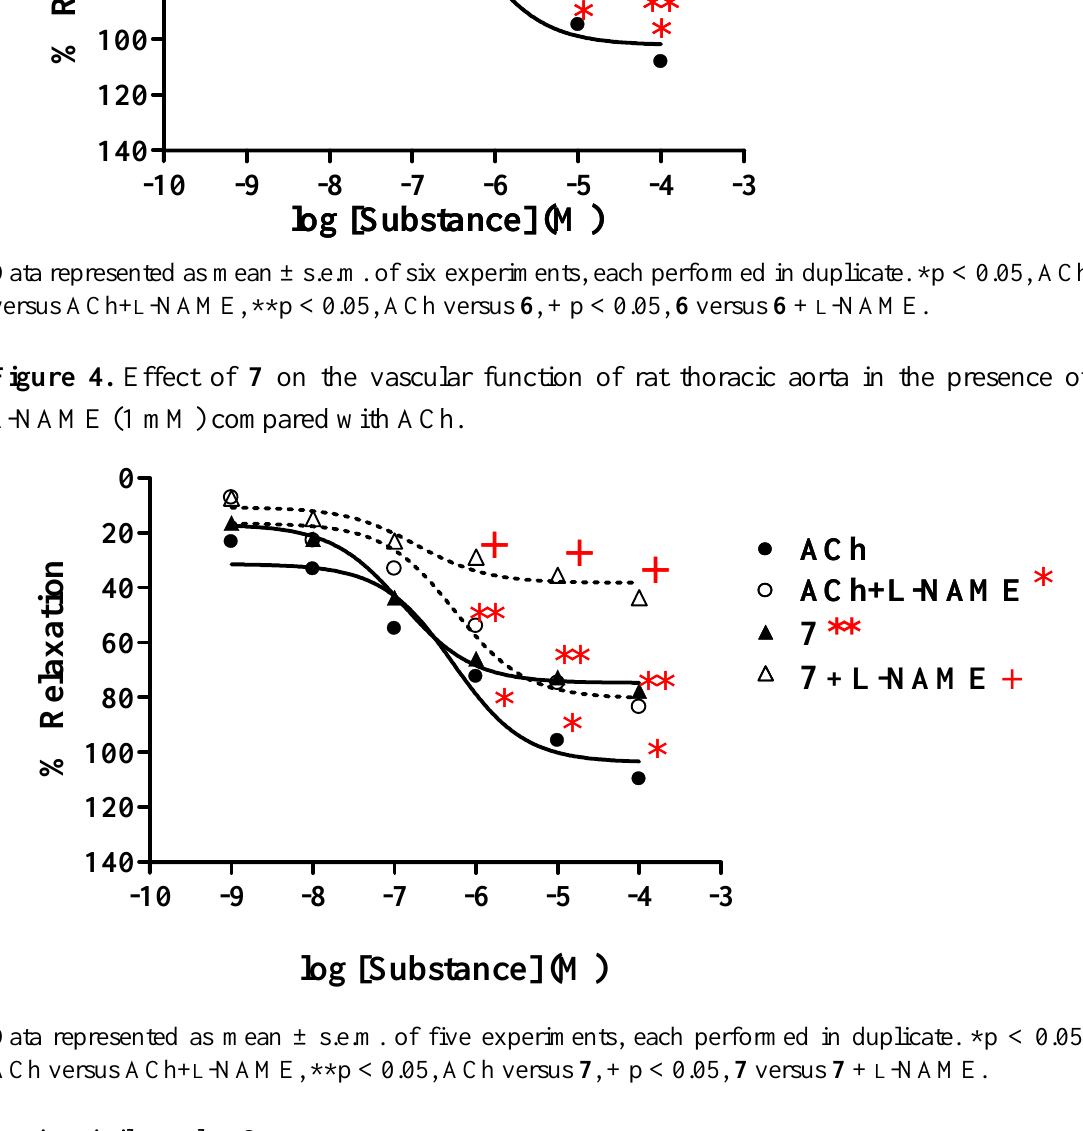
Data represented as mean ± s.e.m. of five experiments, each performed in duplicate. *p <